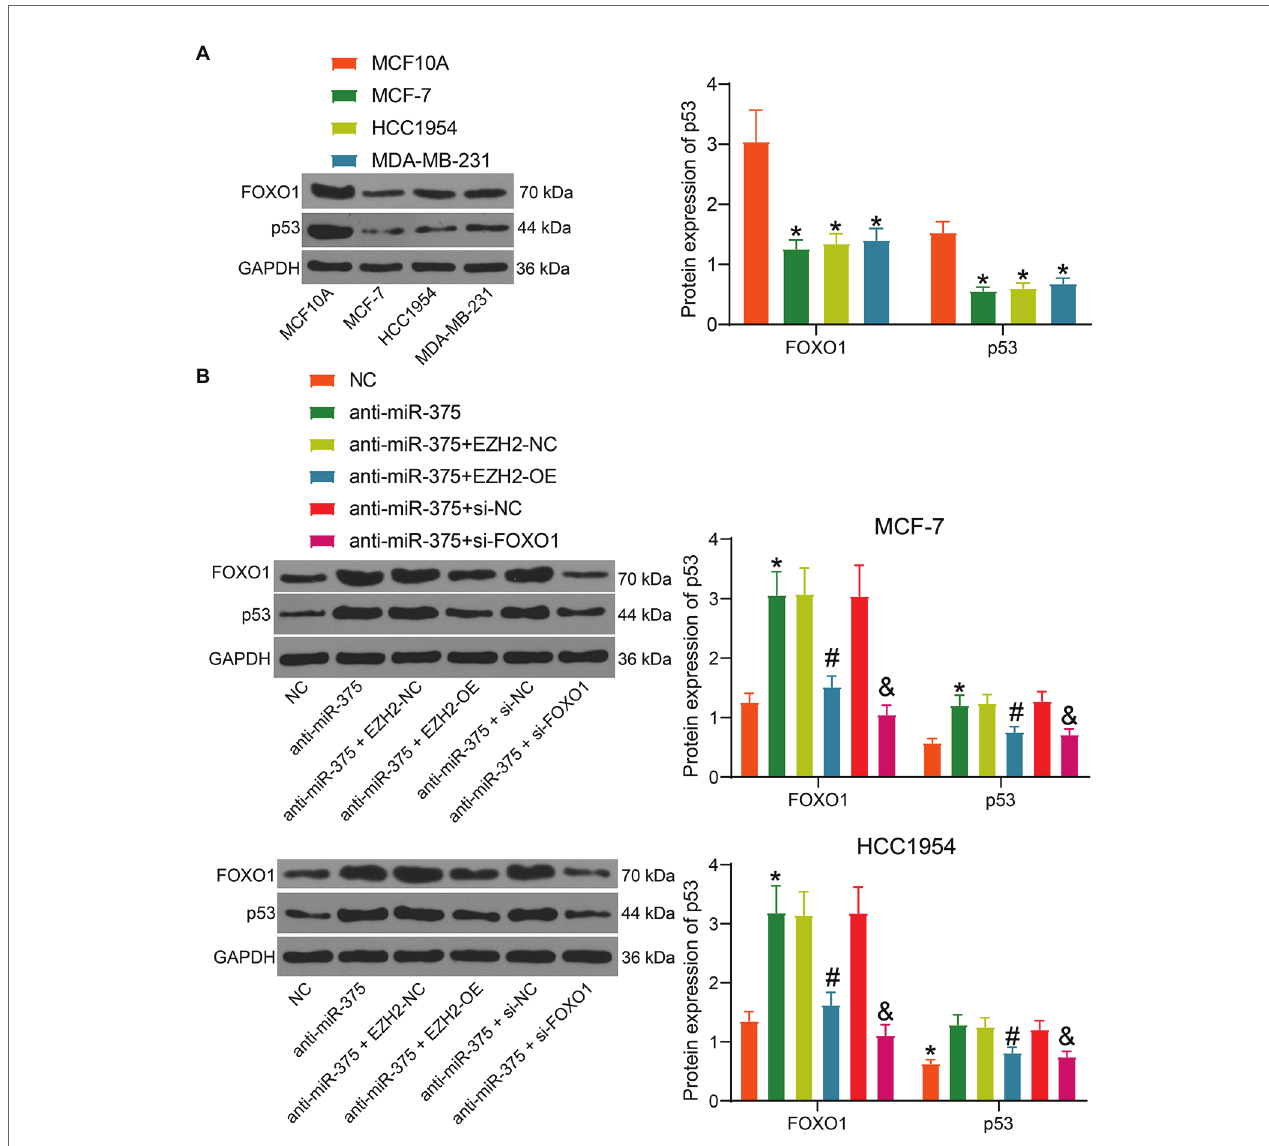
FIGURE 7 | The EZH2/miR-375/FOXO1 axis mediates the activity of the p53 signaling pathway. (A) Protein level of p53 and FOXO1 in BC cell lines and in normal cells determined by Western blot analysis (* #& p < 0.05, one-way ANOVA); (B) protein level of p53 in MCF-7 and HCC1954 cells after anti-miR-375, EZH2-OE, and si-FOXO1 transfection determined by Western blot analysis (* #& p <0.05, one-way ANOVA, *, NC vs. anti-miR-375; #, anti-miR-375 + EZH2-NC vs. anti-miR-375 + EZH2-OE, & anti-miR-375 + si-NC vs. anti-miR-375 + si-FOXO1). Data were presented as mean + SD from three independent experiments. In animal models, n = 3 in each